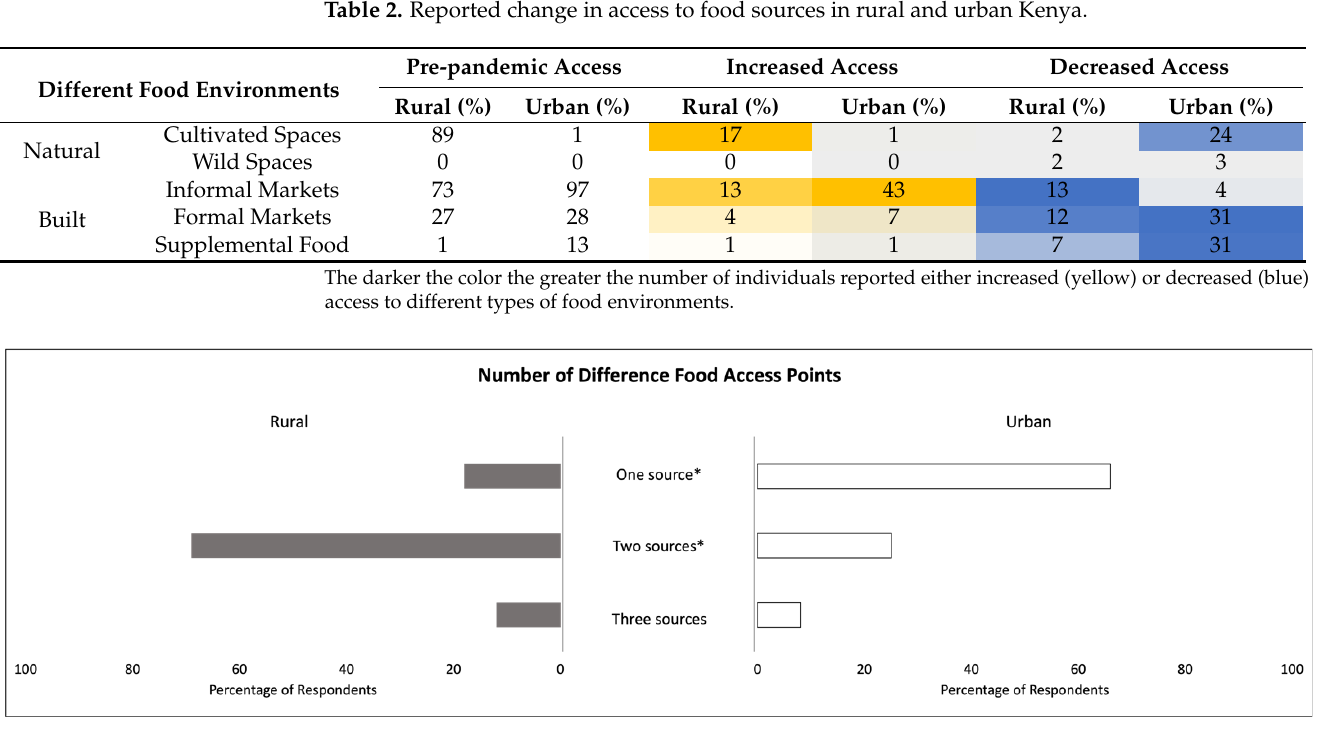
Figure 3. Reported number of food access points in urban ( n = 144) and rural ( n = 173) Kenya. * Statistically significant at p < 0.05 ( χ 2 test).